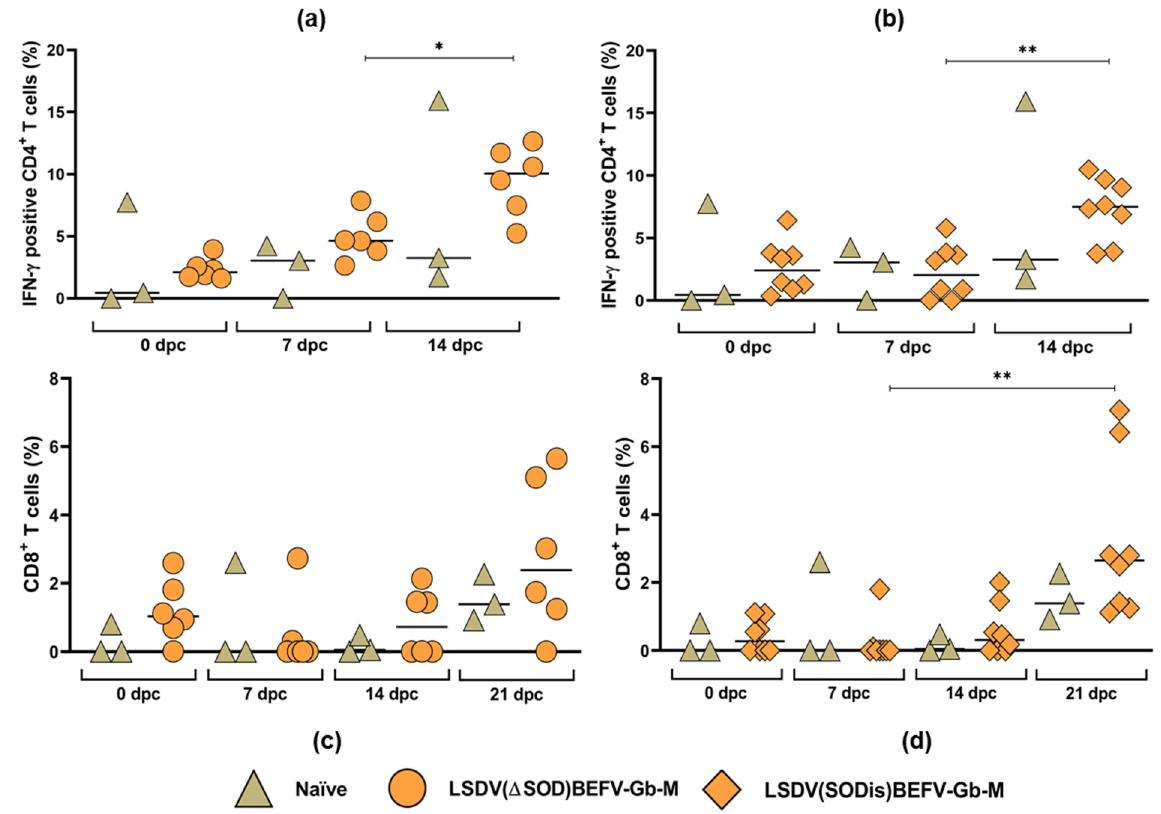
Figure 12. T cell responses to LSDV following virulent LSDV challenge. Whole blood was stimulated with LSDV for 24 h and IFN γ -secreting CD4 + and CD8 + T cells were measured. ( a , b ) the average % IFN γ - secreting CD4 + T cells from 0–14 dpc from cattle vaccinated with LSDV( ∆ SOD)BEFV-Gb-M (circles) and LSDV(SODis)BEFV-Gb-M (diamonds), respectively; ( c , d ) the average % CD8 + T cells from 0–21 dpc from cattle vaccinated with LSDV( ∆ SOD)BEFV-Gb-M (circles) and LSDV(SODis)BEFV-Gb-M (diamonds), respectively; the green diamonds represent unvaccinated naïve cattle. Statistical analyses were conducted using Welch one-way ANOVA with Dunnett’s T3 multiple comparison test ( a , b ) and Kruskal–Wallis test with Dunn’s multiple comparison test ( c , d ). Horizonal lines indicate median values. * p < 0.05, ** p < 0.01.